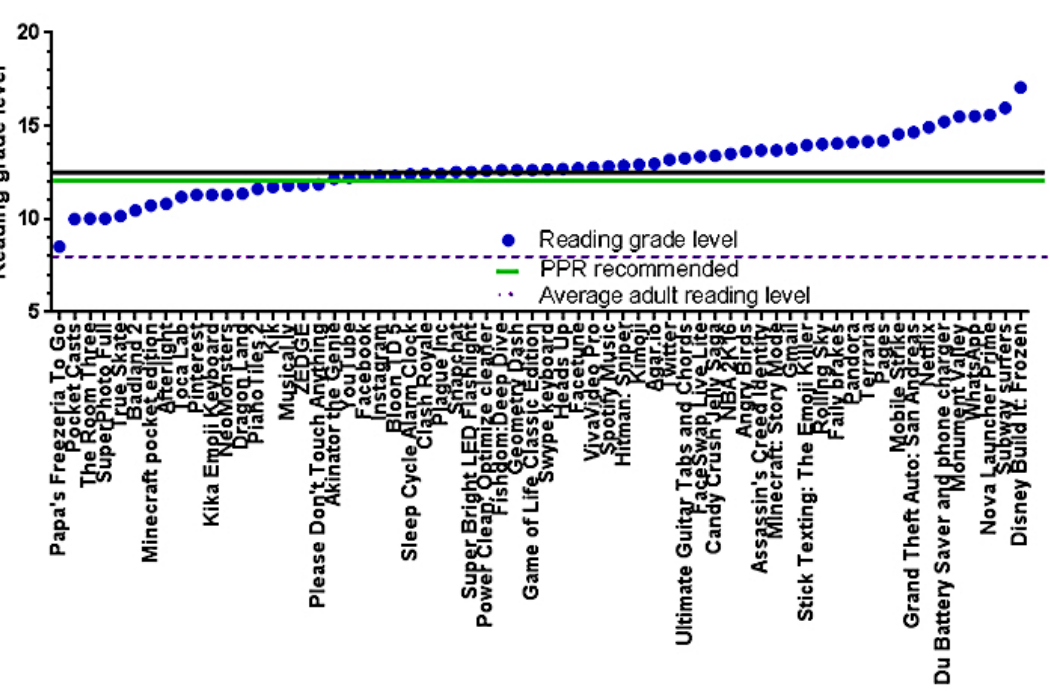
Figure 3. Privacy policy reading grade level (RGL; N=64). The RGL was an average of the Flesch-Kincaid, Gunning Fog, and simplified measure of Gobbledygook (SMOG) RGLs. The mean RGL of all the apps was 12.78, which is equivalent to a freshman in college. This average level is also higher than the Patient Privacy Rights (PPR) recommended RGL of 12.00 and higher than the US average adult RGL of 8.00. In terms of the individual apps, the highest RGL was for Disney Build It: Frozen at 17.07, which is equivalent to a graduate student reading level. The lowest RGL was for Papa’s Freezeria To Go at